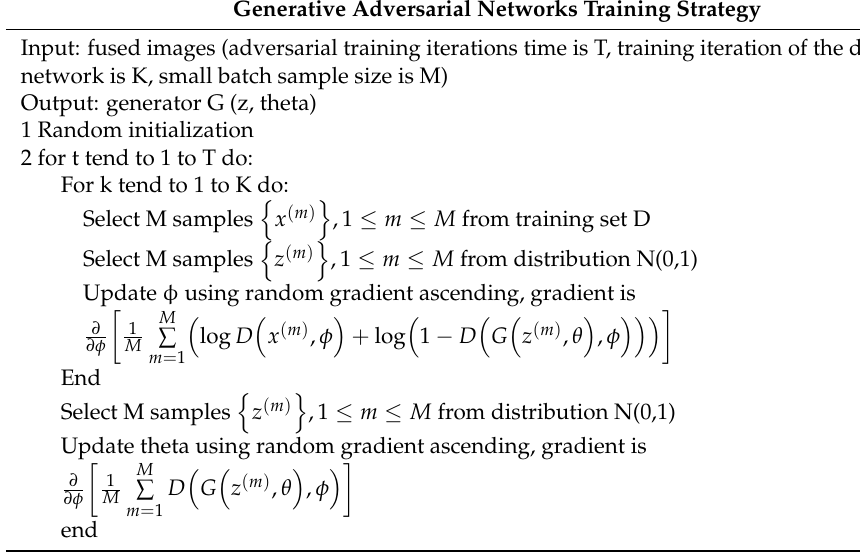
Table 2. The GAN augmentation training process. Generative Adversarial Networks Training